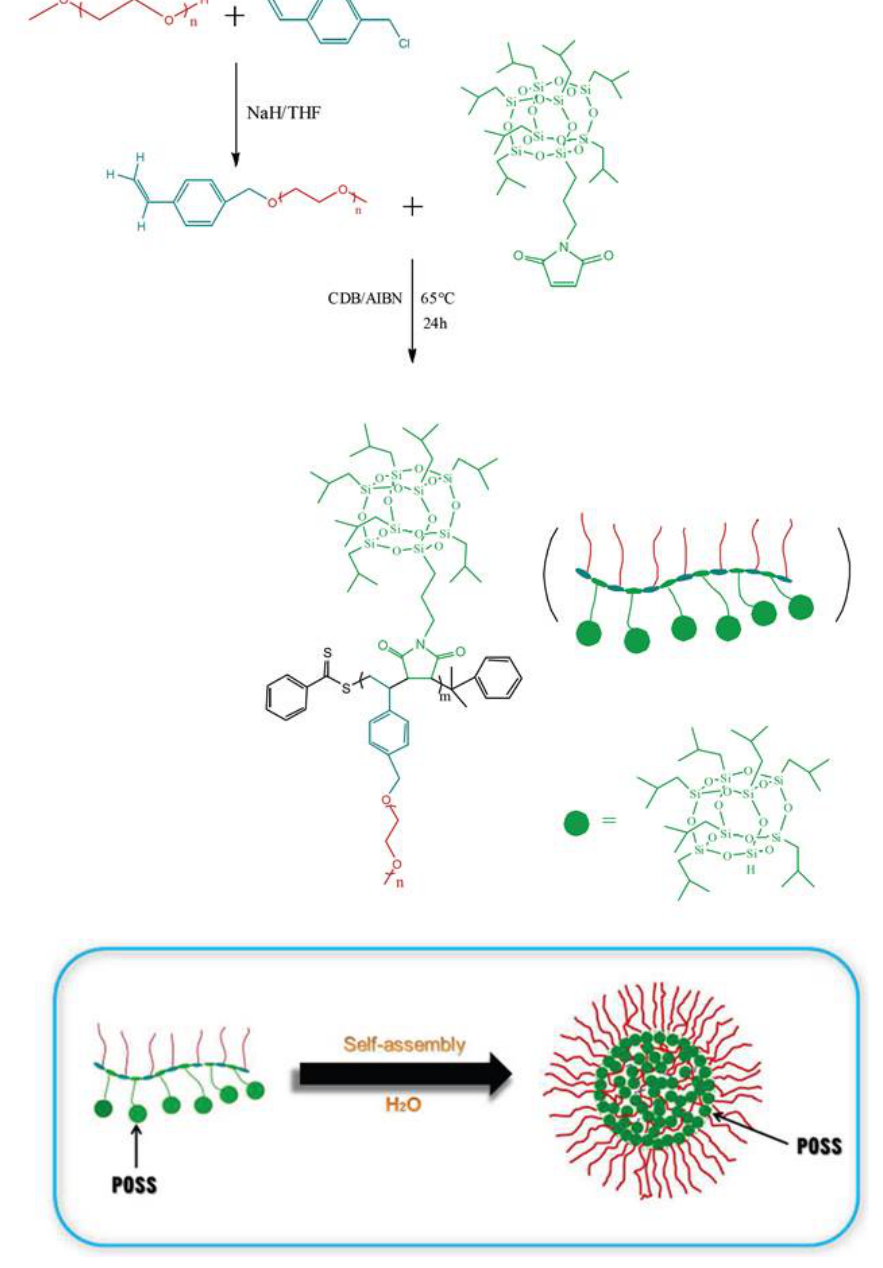
Figure 10. Schematic illustration of the synthesis of poly(maleimide isobutyl polyhedral oligomeric silsesquioxane- alt -vinylbenzyl polyethylene glycol) (P(MIPOSS- alt -VBPEG)) by RAFT polymerization and self-assembly of P(MIPOSS- alt -VBPEG) 2 . Reprinted with permission from [37]. Copyright (2015) the Centre National de la Recherche Scientifique (CNRS) and The Royal Society of Chemistry.